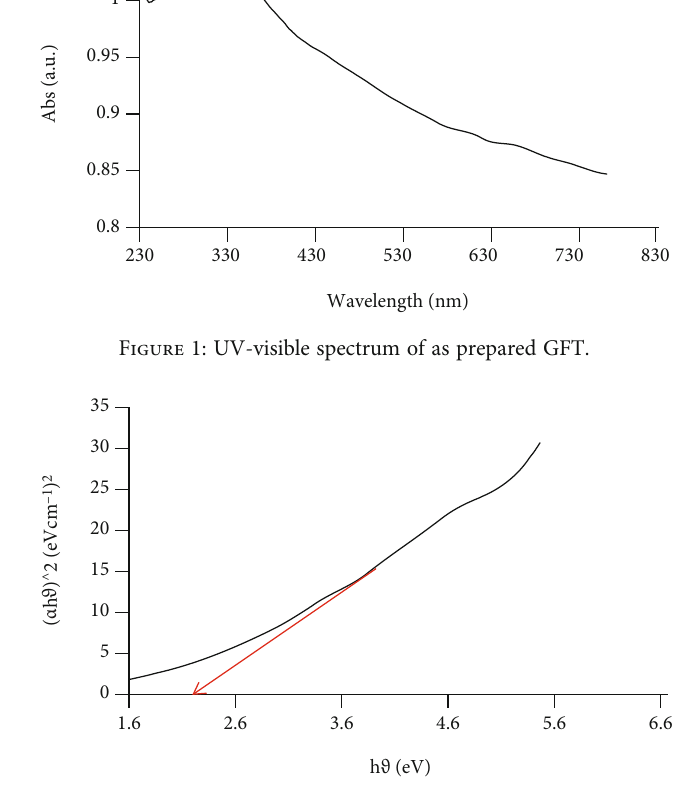
Figure 2: Band gap determination of GFT by linear